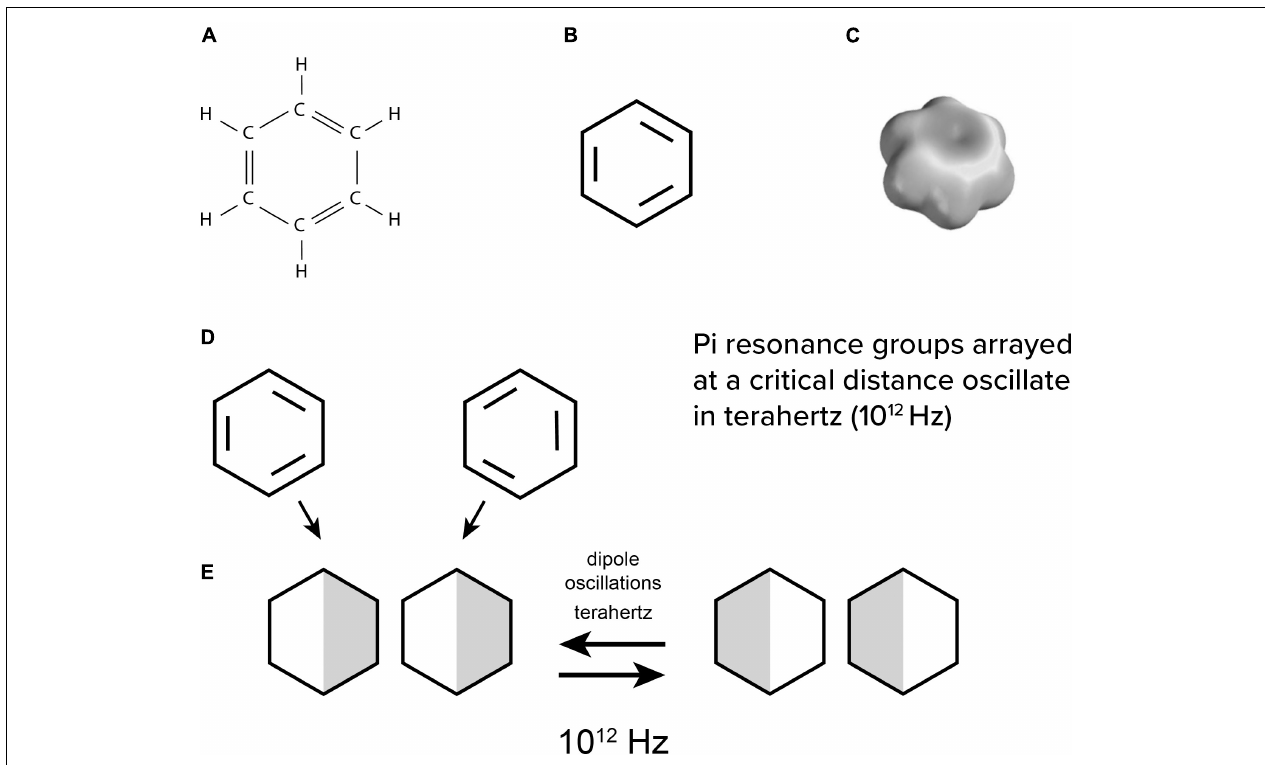
FIGURE 4 | (A) chemical structure of benzene, (B) simplified with 3 extra electron bonds, and (C) with a delocalized electron cloud enveloping the ring. (D) individual benzene rings attract by induced dipoles which then (E) oscillate in